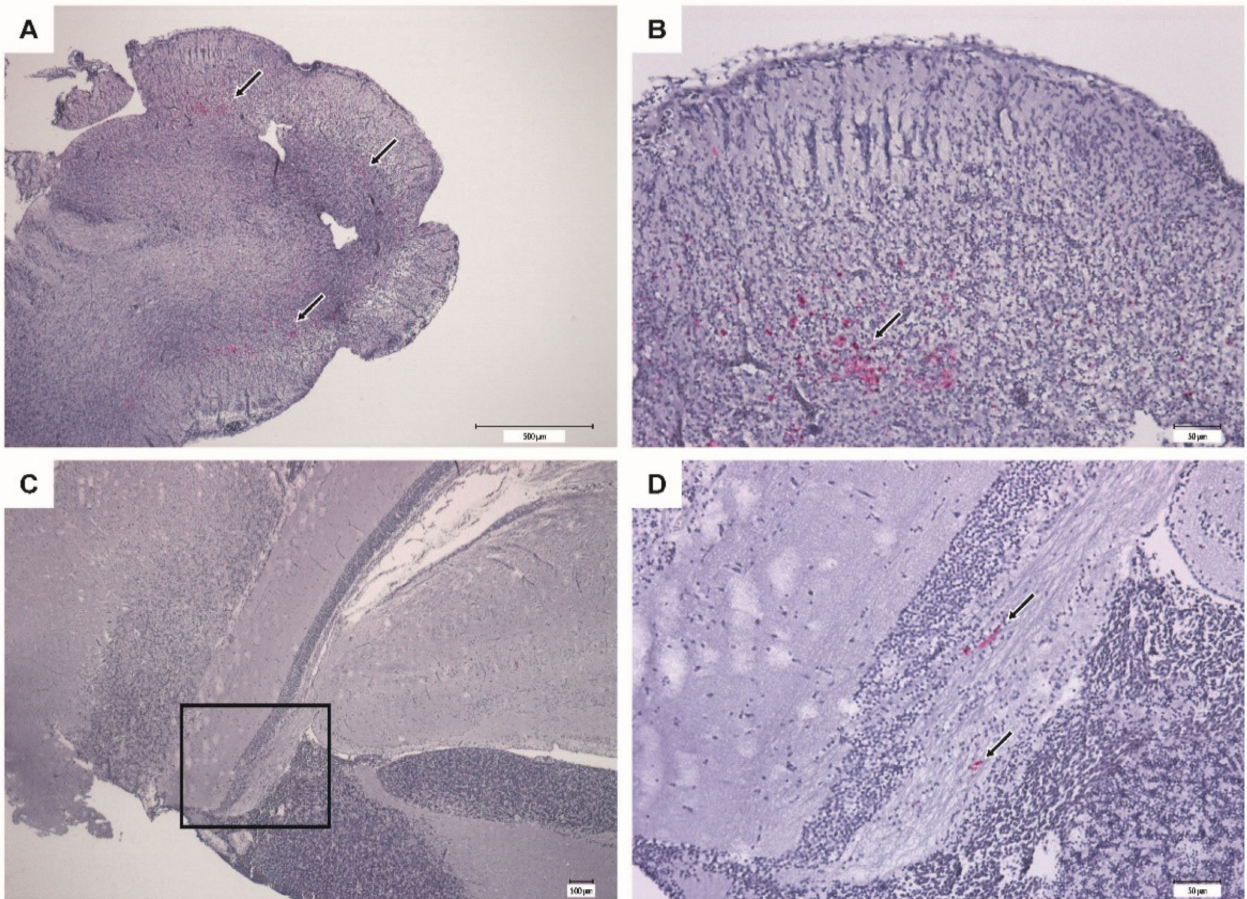
Figure 10. Immunohistochemistry of brain from vaccinated surviving sea bass (VLP 20 µ g/fish). Bright red immunostaining indicates the presence of RGNNV antigens. ( A , B ) Cerebellum at different magnifications showing mild coloring (arrows). ( C , D ) Mesencephalon with scattered staining (arrows). ( D ) Higher magnification of the squared section in ( C